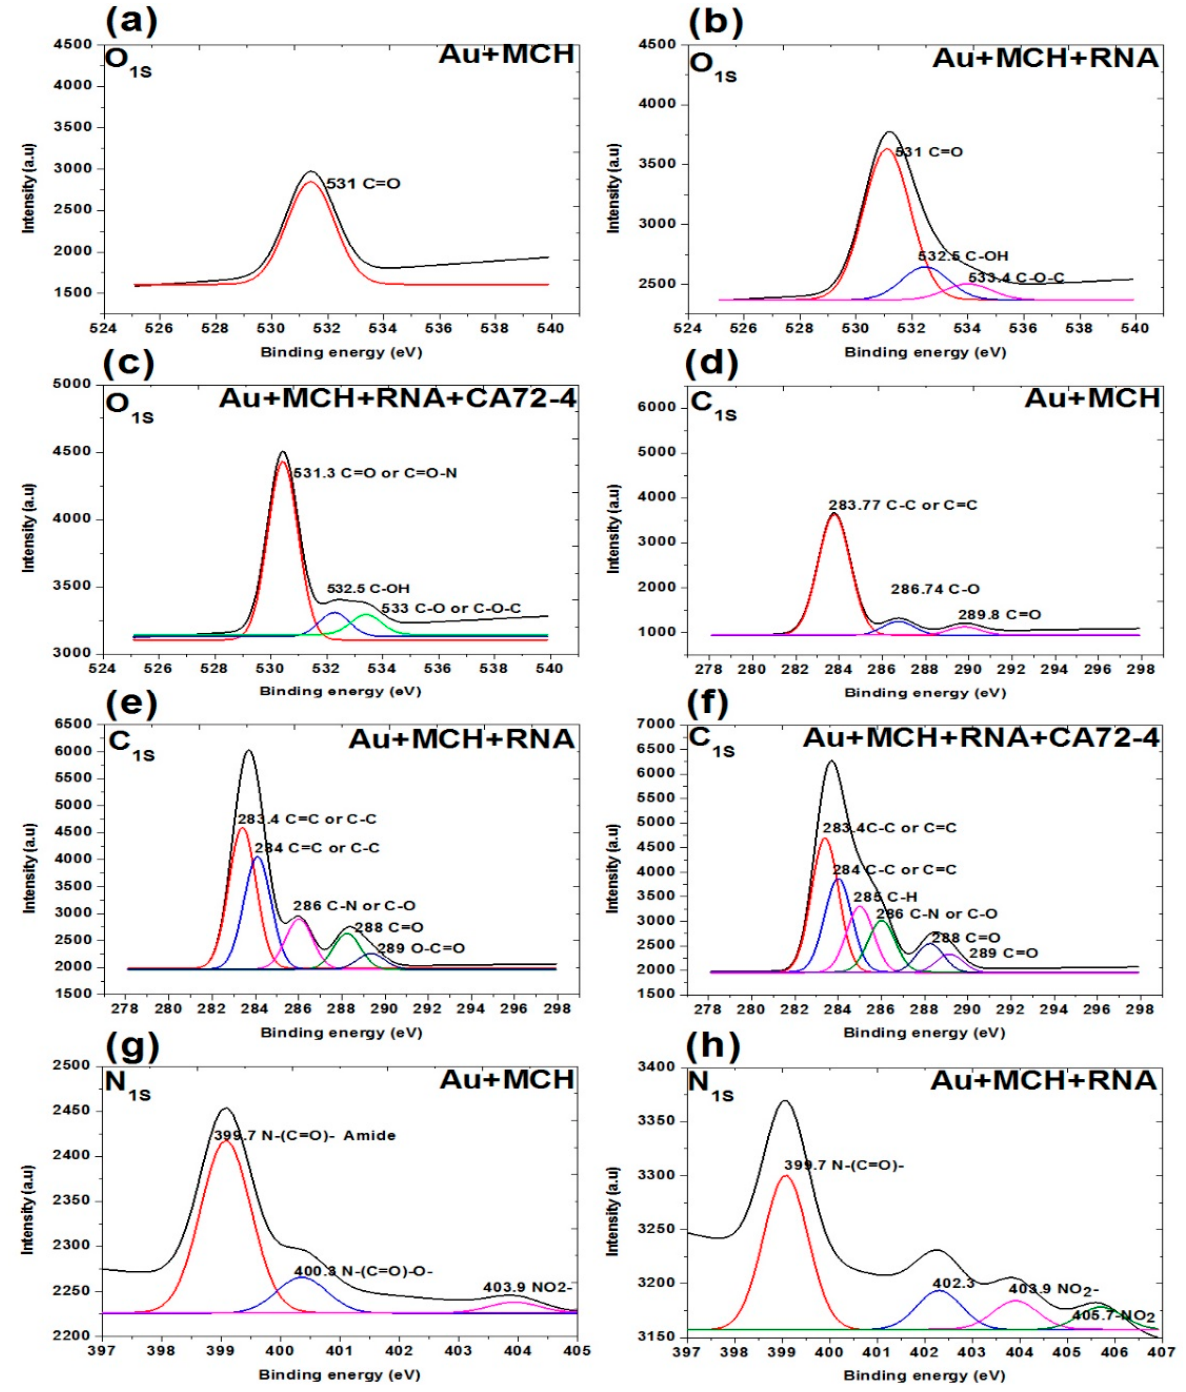
Figure 7. XPS analysis of adsorption of different concentrations of cancer antigen CA 72-4 on our electrochemical sensor. ( a ) O 1s analysis of MCH-modified gold-coated membrane. ( b ) O 1s studies on the Oligo-RNA membrane. ( c ) O 1s results of Oligo-RNA-modified and detected CA72-4. ( d ) C 1s region of MCH-modified gold membrane. ( e ) C 1s region of Oligo-RNA. ( f ) C 1s region of Oligo-RNA and CA72-4. ( g ) N 1s region of MCH-modified gold membrane. ( h ) N1s region of Oligo-RNA.